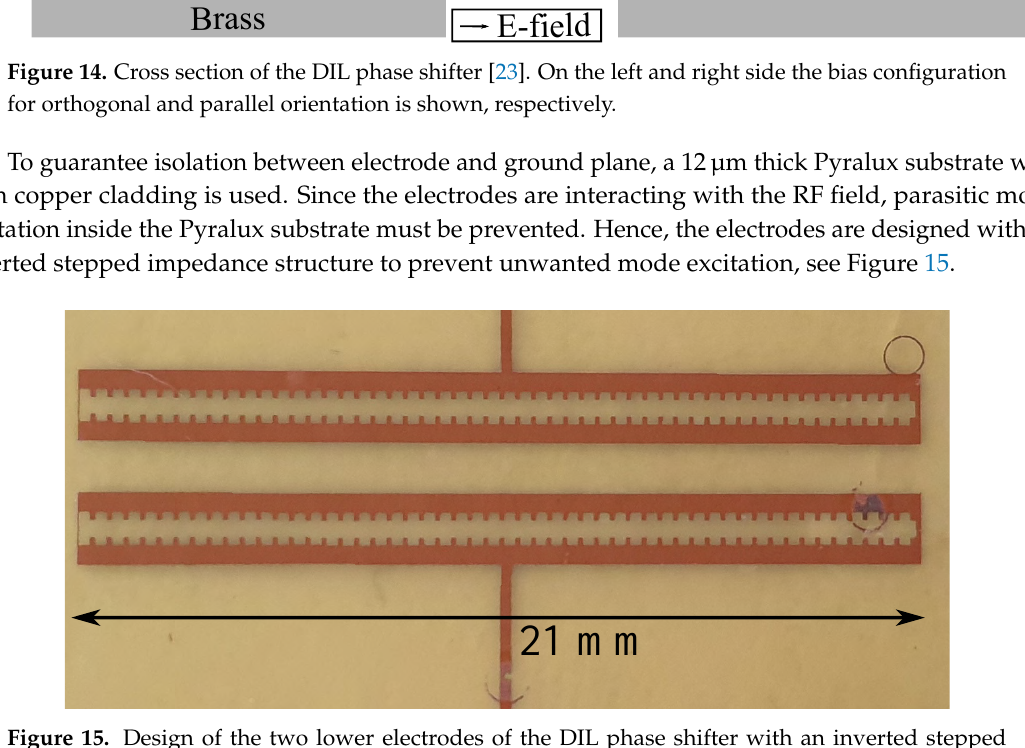
Figure 15. Design of the two lower electrodes of the DIL phase shifter with an inverted stepped impedance structure to prevent parasitic mode